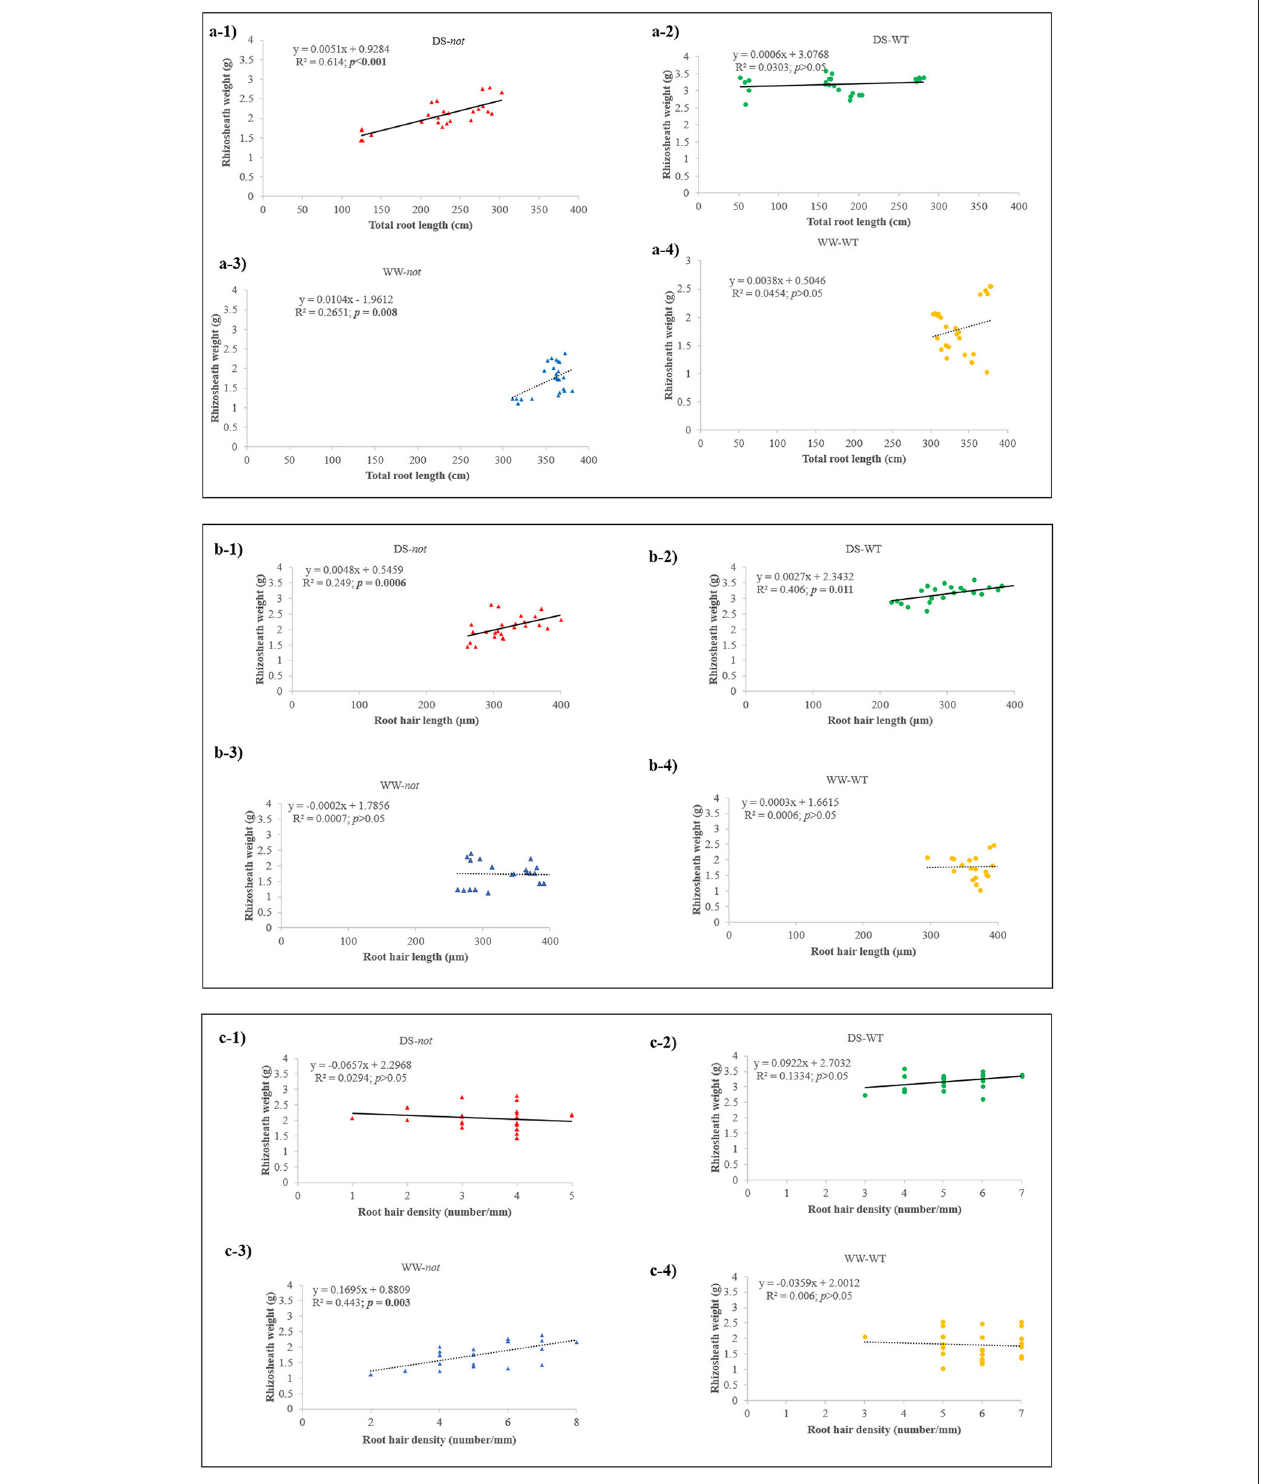
FIGURE 2 | Rhizosheath weight plotted against total root length (a1–a4) , root hair length (b1–b4) , and root hair density (c1–c4) . Each point represents an individual plant, and linear correlations of WT and not plants were fitted where significant ( p ≤ 0.05) P -values are shown in bold for plants grown under drying stress (solid lines) and WW (dashed lines) conditions, with P- values and r 2 reported. WT (orange circles) and not (blue triangles) plants grown under WW conditions; and WT (green circles) and not plants (red triangles) grown under drying stress conditions are indicated. Regression lines are fitted to all panels, with r 2 and P -values indicated.